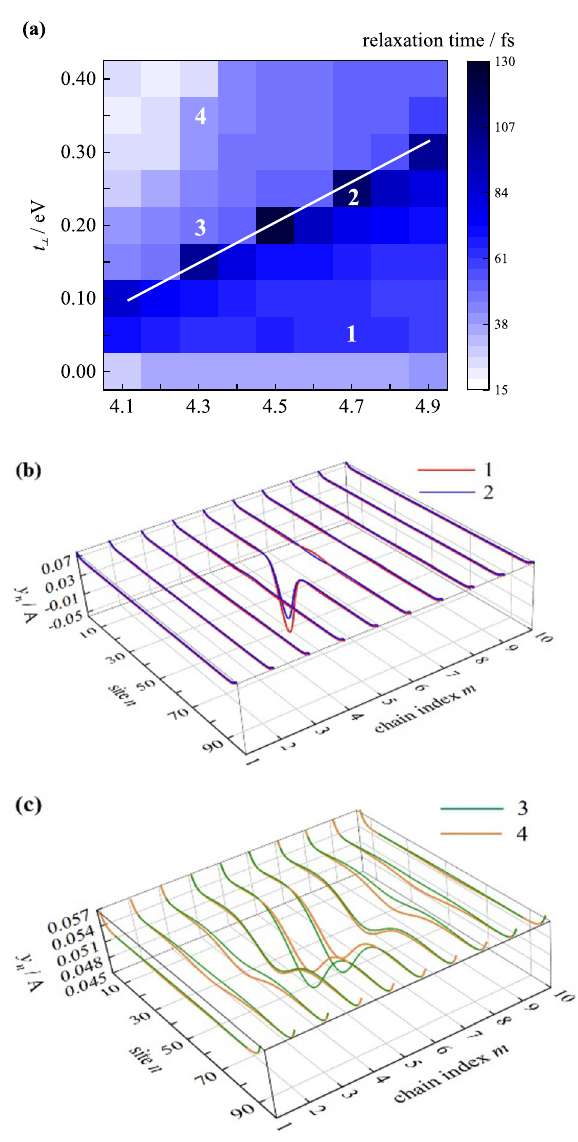
Figure 5. ( a ) The dependence of exciton relaxation time on intermolecular coupling and intramolecular e–p coupling; ( b ) and ( c ) the relaxed lattice displacement of sample points labeled in